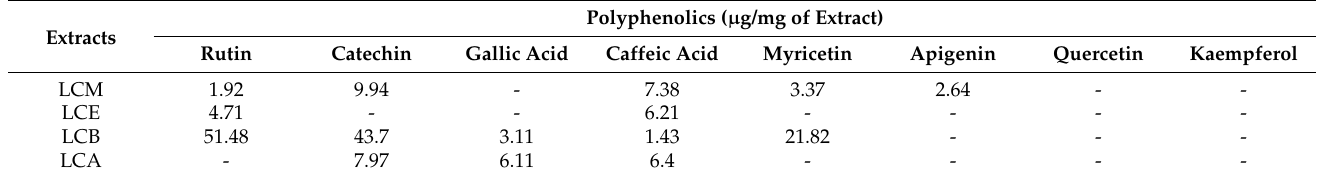
Table 1. Retention time, optimized wavelength and regression analysis of reference flavonoids and phenolics for L. corymbulosum methanol extract and derived fractions. Table 2. HPLC–DAD analysis of L. corymbulosum methanol extract and its derived